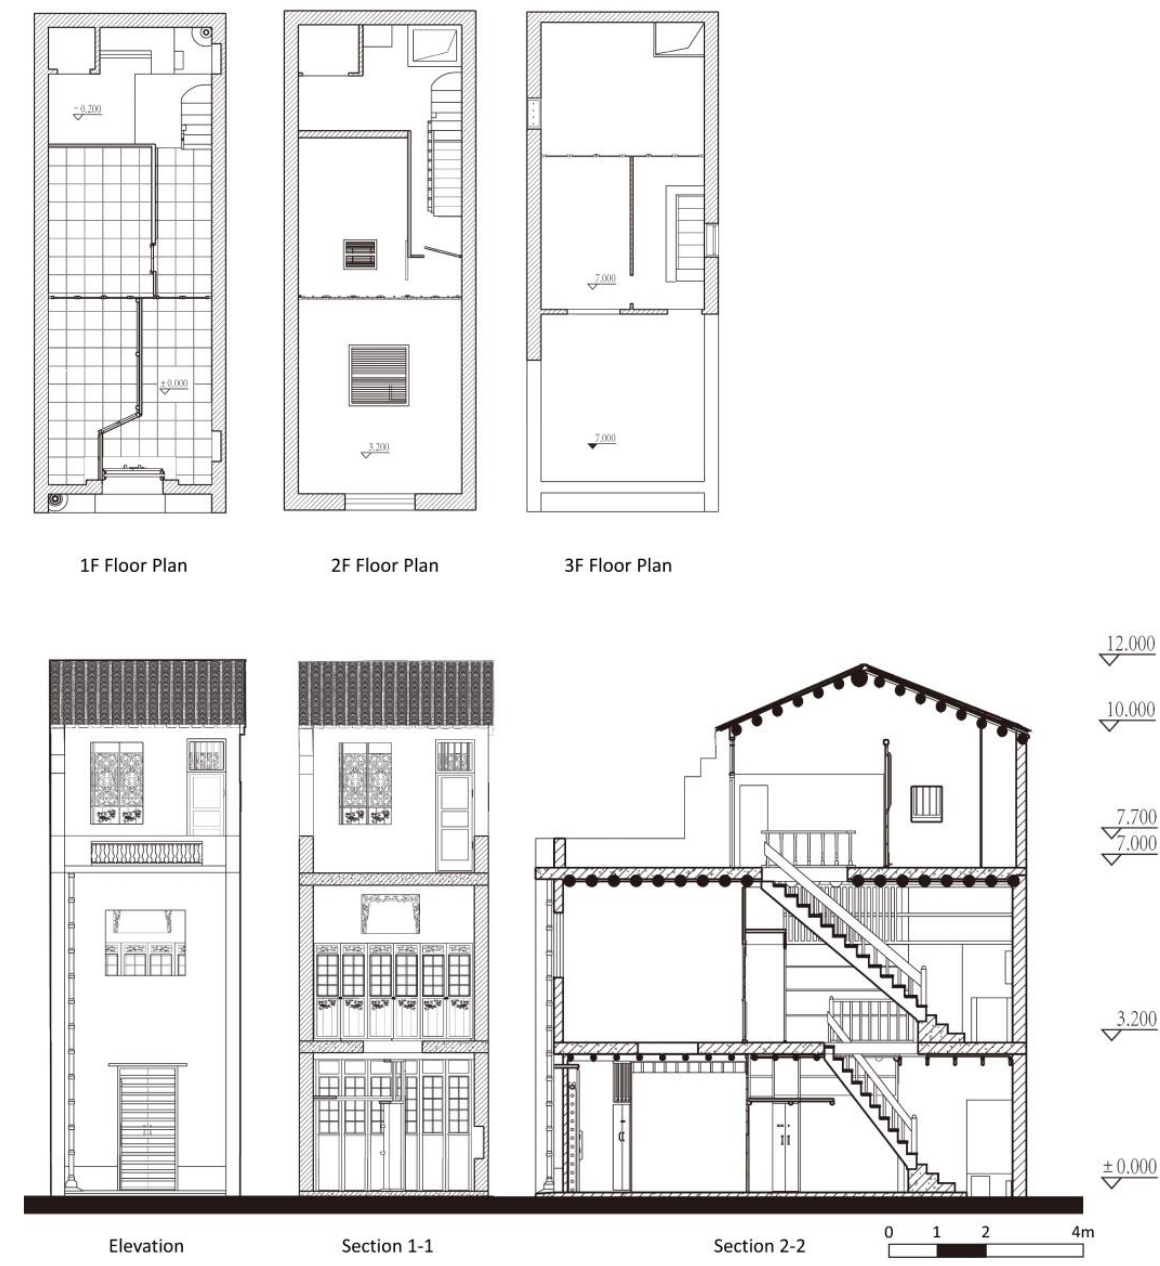
Figure 4. Building floorplans, elevation, and sections (measured and redrawn by students).